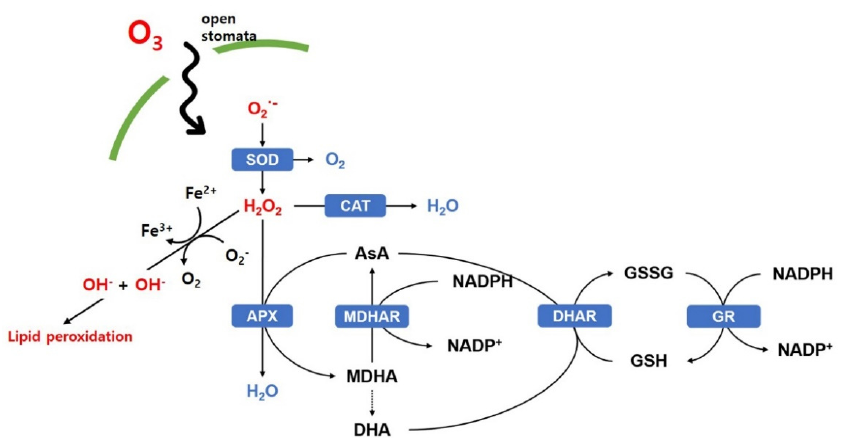
Figure 5. Reactive oxygen species detoxification systems in plants under ozone stress